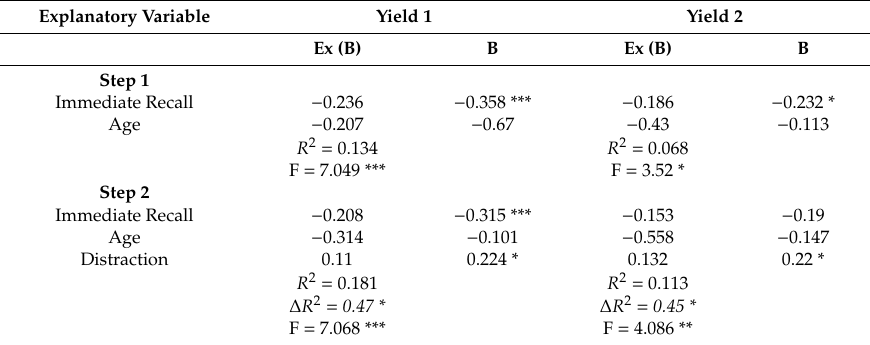
Table A1. Hierarchical linear regression models for Yield 1 and Yield 2 scores ( n =